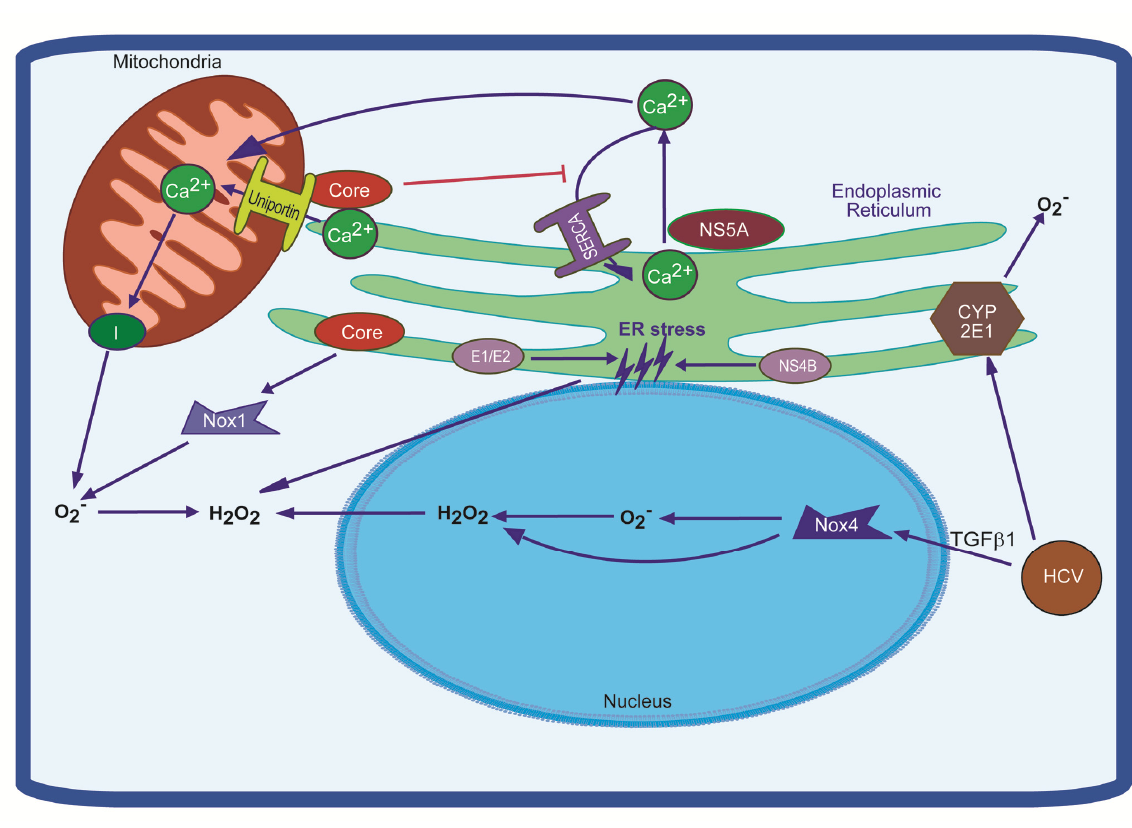
Figure 1. Schematic representation of mechanisms of oxidative stress induction in the HCV-infected cells. They include alteration of functioning of the respiratory chain complex I in response to accumulation of calcium ions in mitochondria. This accumulation is achieved via activation of mitochondrial Ca 2+ uniporter and enhanced passive leakage of the ions from the ER and suppressed SERCA pump, responsible for Ca 2+ import into the ER. In addition, Hepatitis C virus (HCV) proteins induces NADPH oxidases (Nox) 1 and 4 which contribute to production of H O and O 2- . Finally, the ROS (reactive oxygen 2 2 species) can be generated through ER cytochrome P450 2E1 and induced ER stress. See text for further